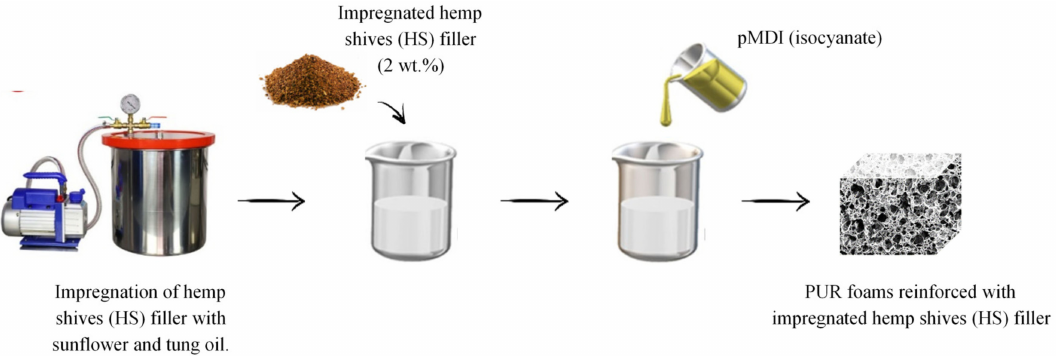
Figure 2. Synthesis of PUR foams reinforced with HS